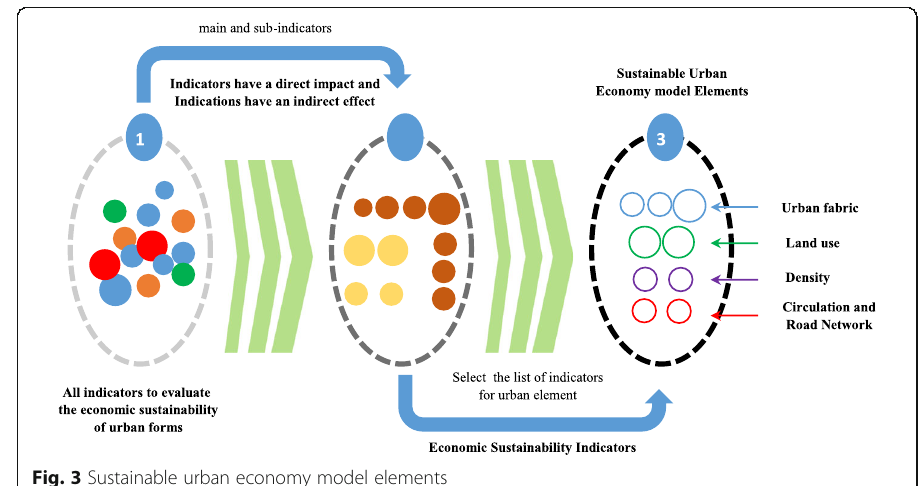
Fig. 3 Sustainable urban economy model